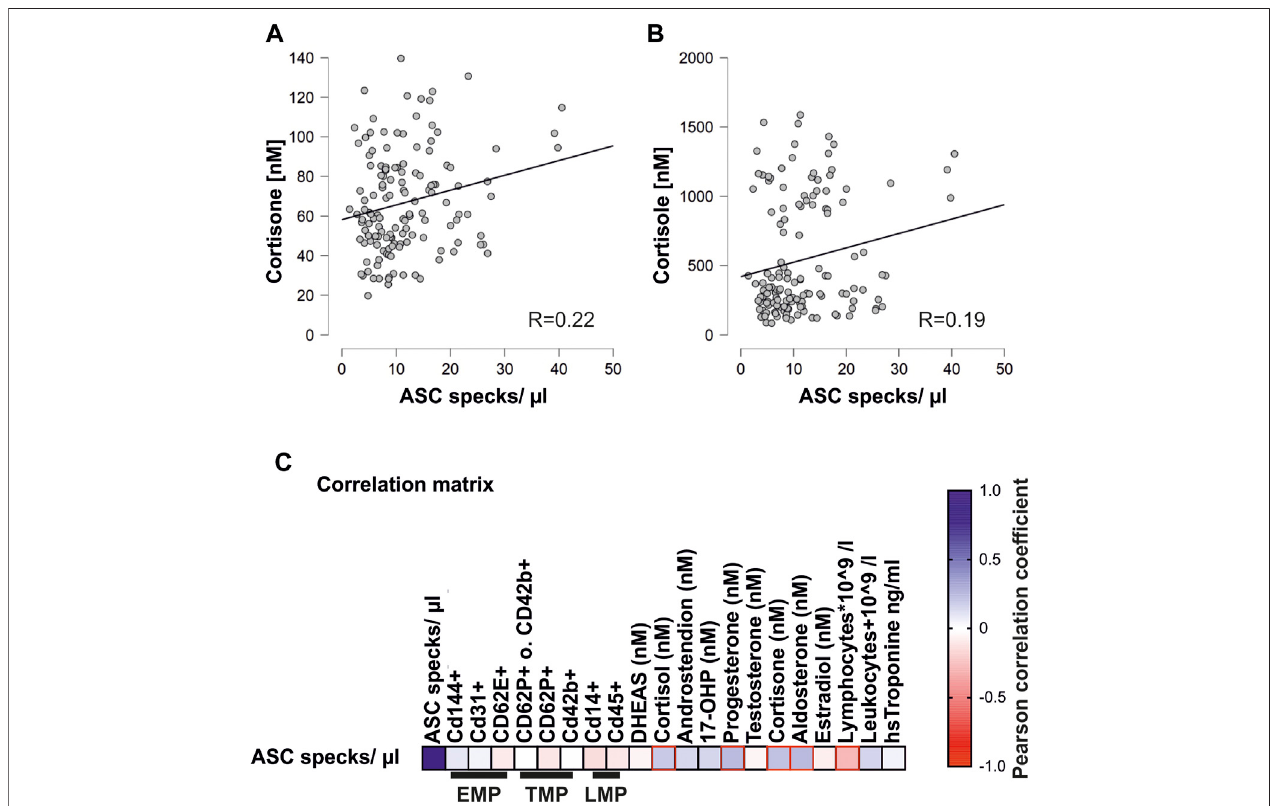
FIGURE3| ConcentrationsofcirculatingASCspeckscorrelatewithsteroidhormonesandlymphocytes (A) PearsoncorrelationmatrixofextracellularASCspecks with various endothelial (EMP), platelet (TMP), and leukocyte (LMP) microparticles and steroid hormones, lymphocytes, leukocytes, and high-sensitivity troponin. Signi fi cant correlations ( p < 0.05) are marked in red. (B,1C) Exemplary scatter plots and linear regression of correlations of extracellular ASC specks with cortisone and cortisol. The Pearson correlation coef fi cient was used to analyze the